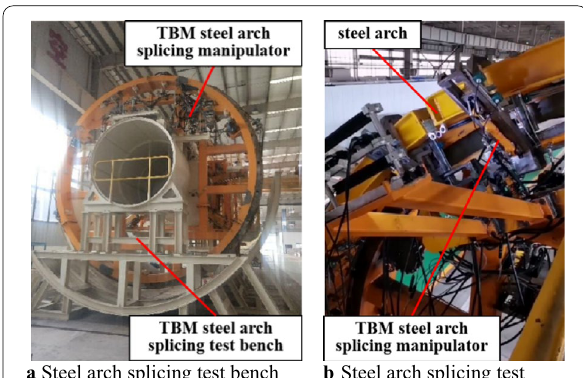
a Steel arch splicing test bench Figure 12 TBM steel arch splicing test